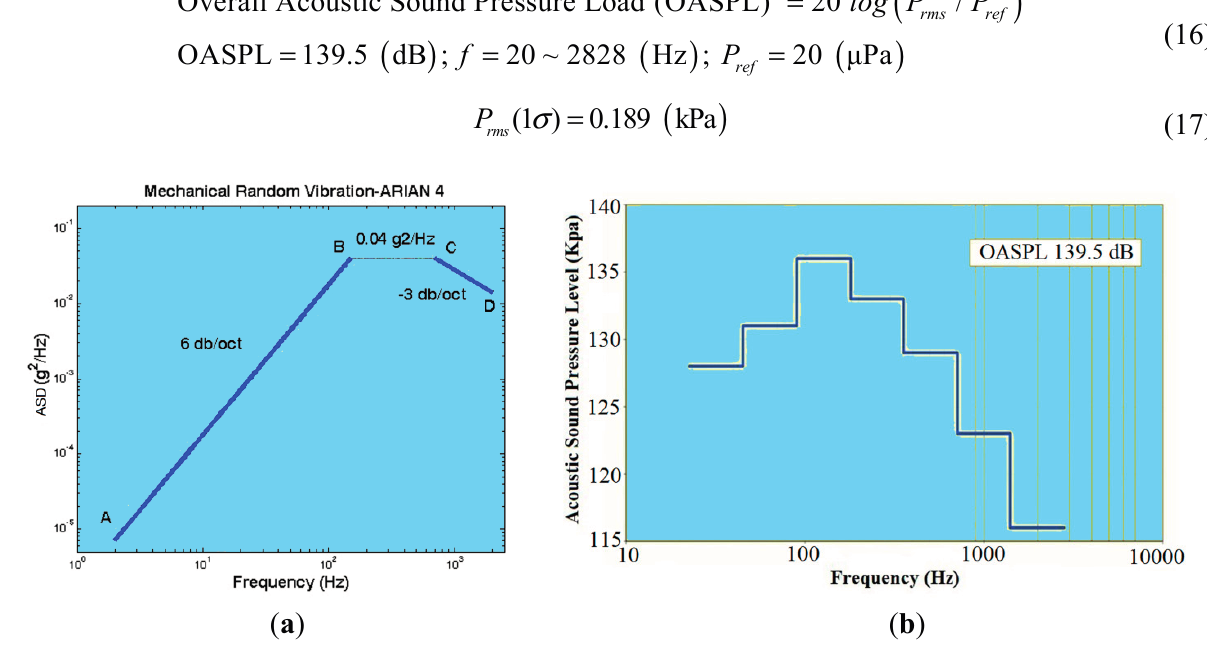
Figure 15. Spectrum for inside the fairing of the Ariane launch vehicle. ( a ) Acceleration spectral density (ASD; g 2 /Hz) for mechanical random vibration, adapted from [20]; ( b ) noise spectrum (dB–Hz) for acoustical random vibration, adapted from